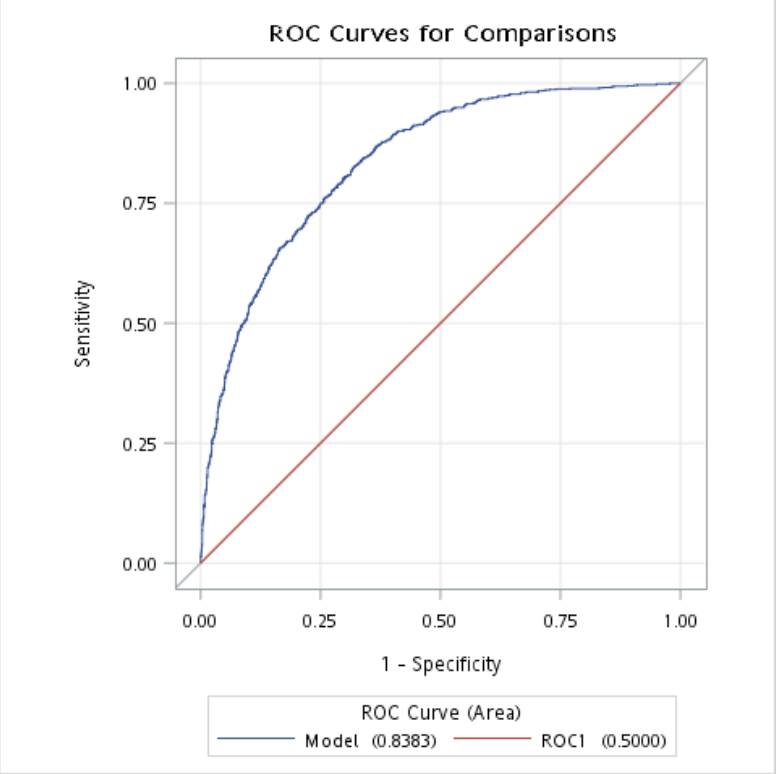
Figure 2. The AUROC of NPAR for NAFLD in individuals without DM. AUROC, area under the receiver operating characteristic curve; DM, diabetes mellitus; NAFLD, nonalcoholic fatty liver dis- ease; NPAR, neutrophil-percentage-to-albumin ratio. This analysis was adjusted for age (continu- ous), gender, race, BMI, smoking, hypertension, and history of CVD.